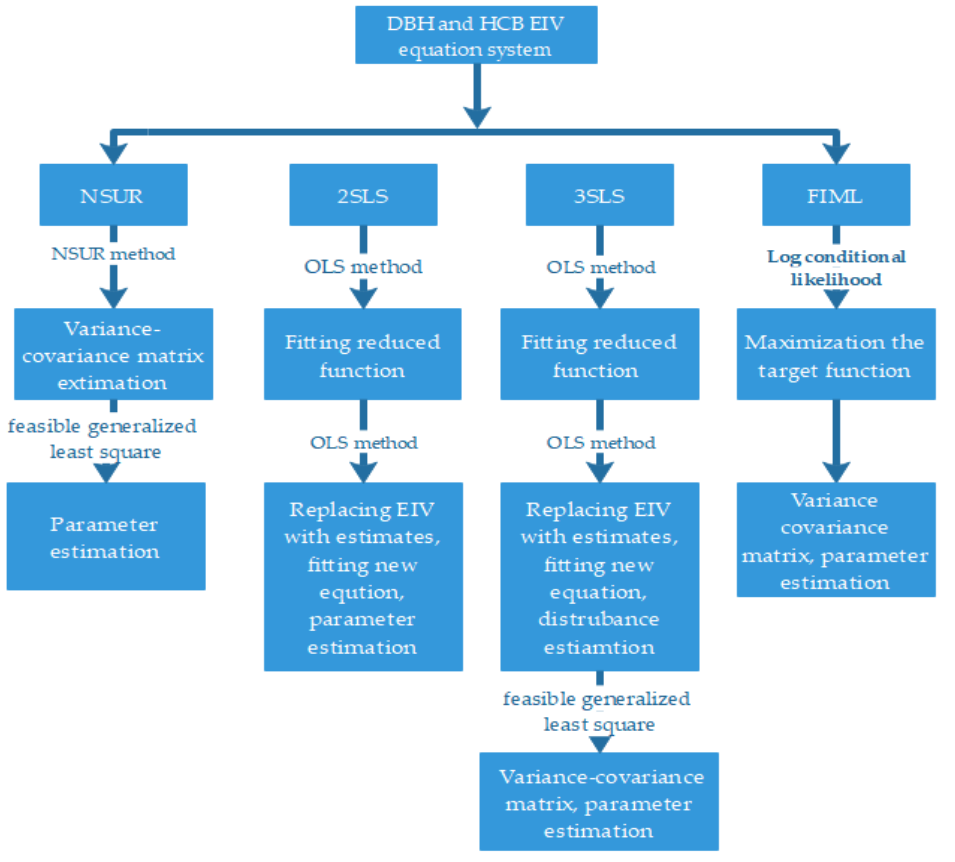
Figure 6. A flow chart depicting a brief description of four algorithms (NSUR, nonlinear seemingly unrelated regression; 2SLS, two-stage least square; 3SLS, three-stage least square; and FIML, full information maximum likelihood) used to estimate a DBH and HCB error-in-variable (EIV) equation system.